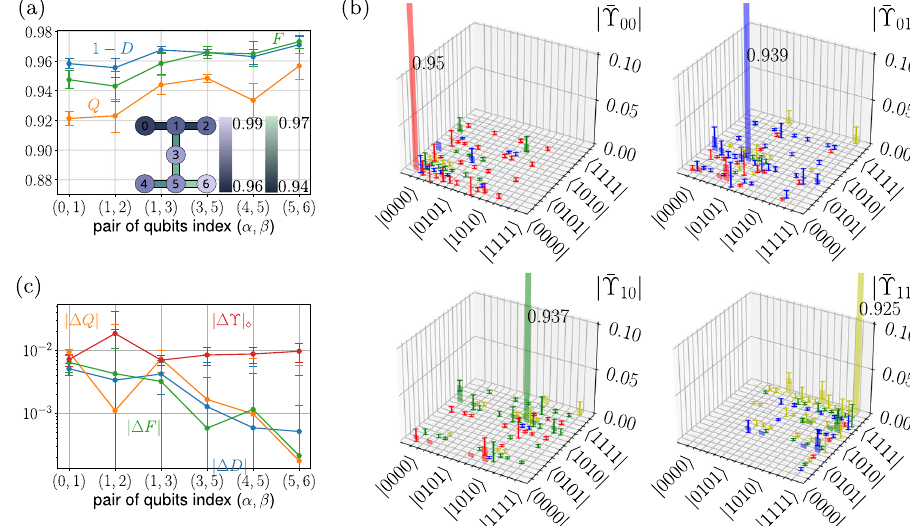
Fig. 3 Experimental tomographic characterization of two-qubit measurements over every pair of connected qubits in parallel. a Measurement quanti fi ers F , Q , and 1 − D for each nearest-neighbor pair. The inset represents the average performance ( F + Q + 1 − D )/3 in the device of each qubit (blue color code in circles) and of every pair of connected qubits (green color code in bars). b Reconstructed two- qubit Choi matrices ϒ nm averaged over all connected pairs of qubits for the four possible outcomes with n , m = 0, 1. c Error in the quanti fi ers F , Q , and 1 − D and the Choi operators introduced by the parallelization. Error bars are the standard deviation estimated with 5 realization of the